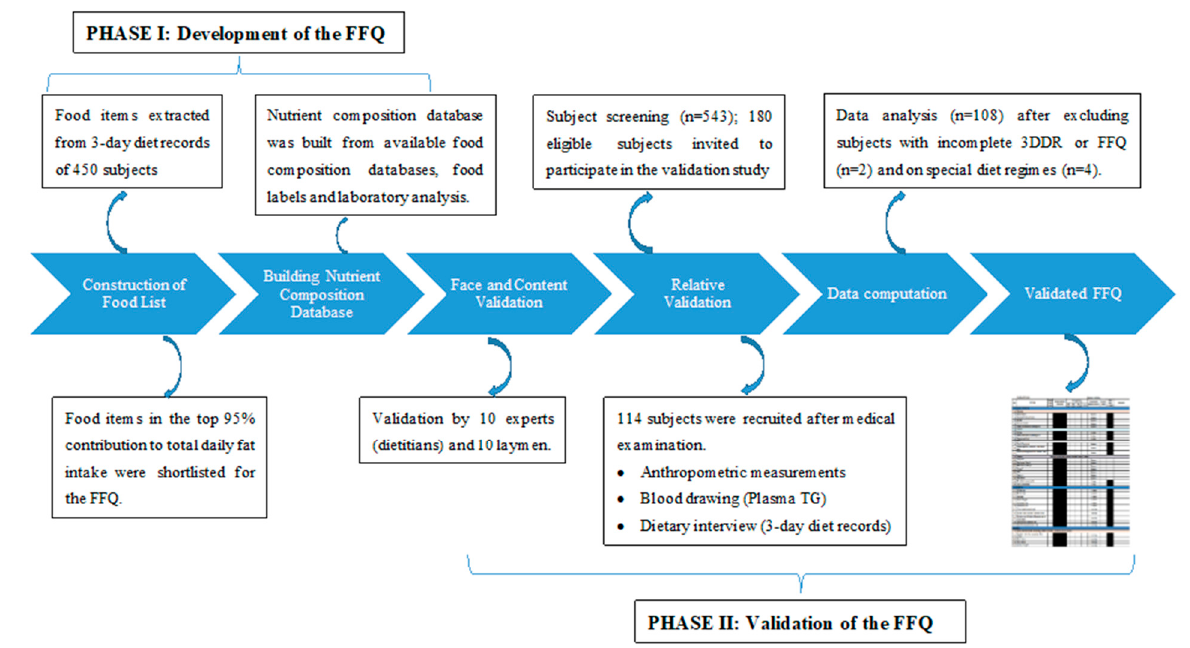
Figure 1. Process algorithm for development and validation of the MLS-FFQ.